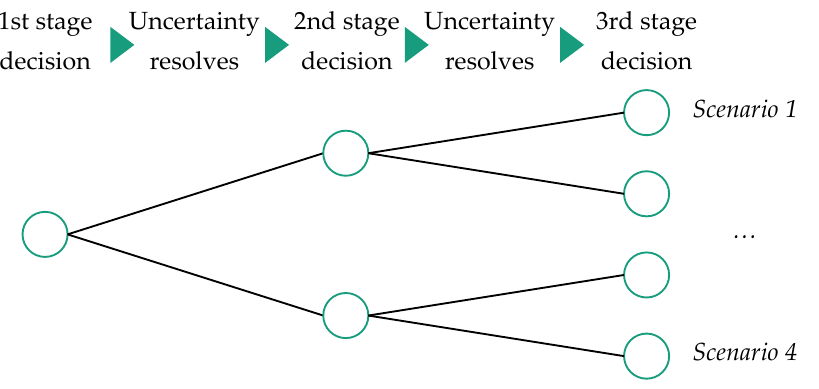
Figure 2. Decision tree for a multi-stage SP model (three stages) based on [51].